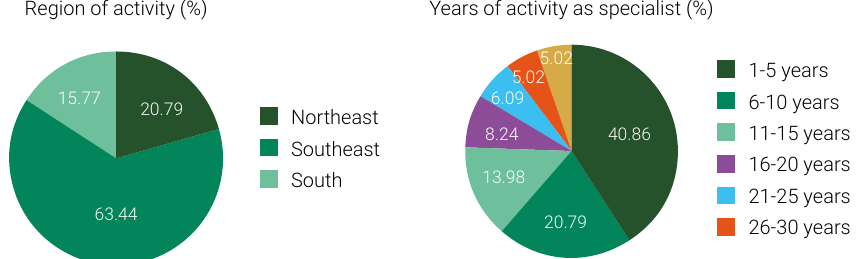
Region of activity (%)